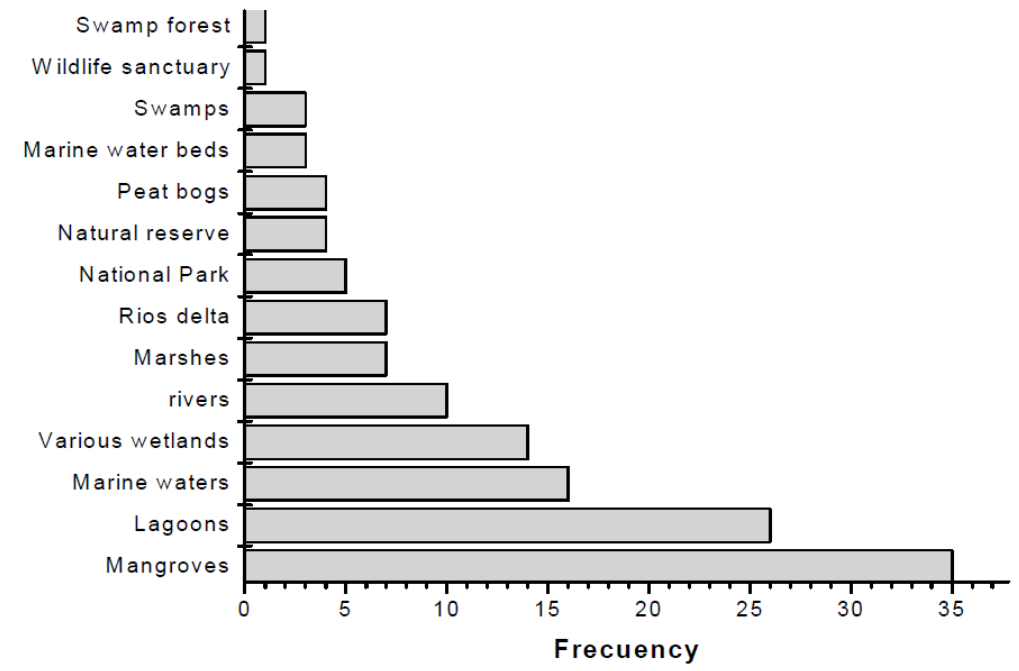
Figure 14. Frequency Distribution of Affected Wetlands at a Global Level.